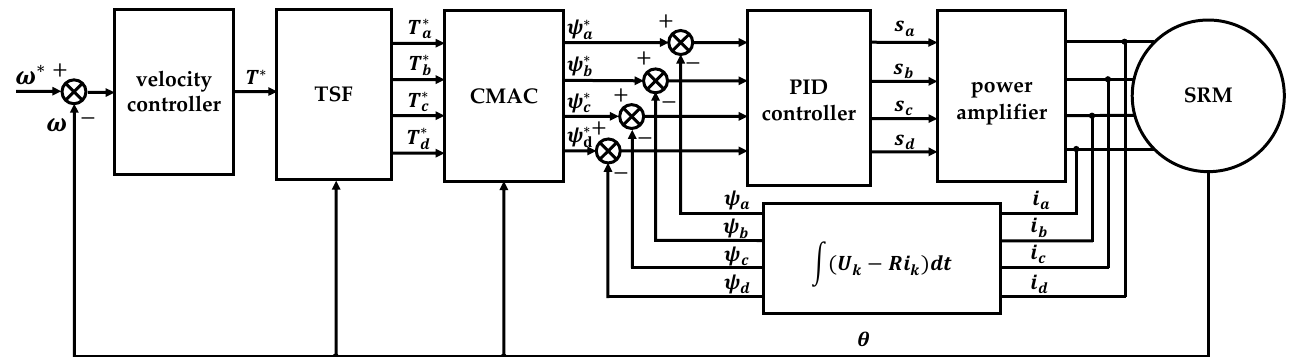
Figure 2. Torque control scheme based on TSF for a 4-phase SRM.